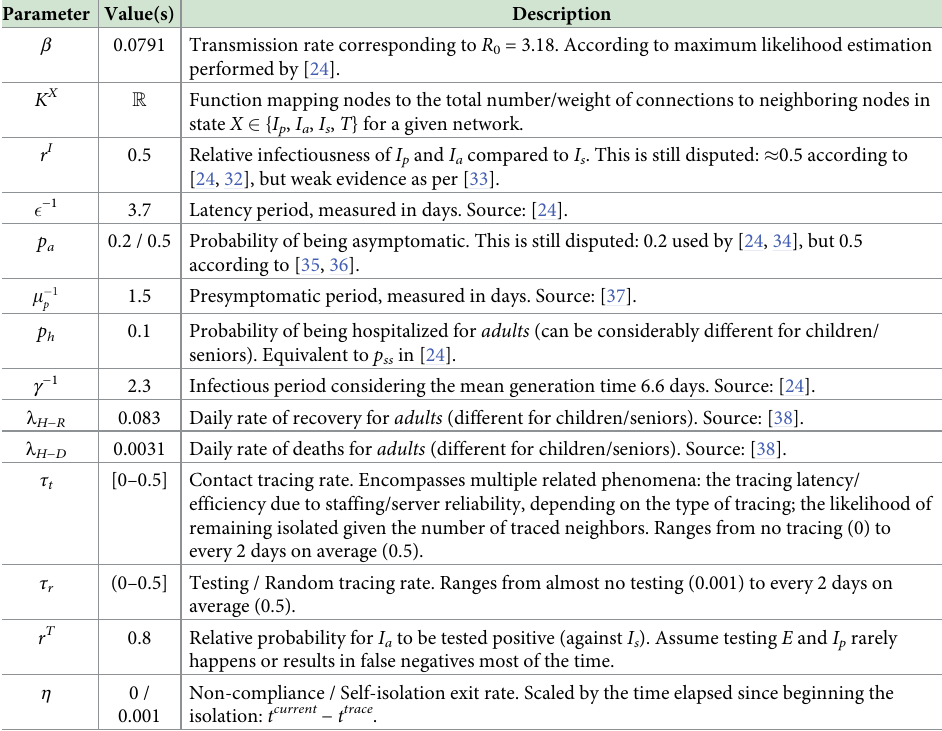
Table 1. Compartmental model